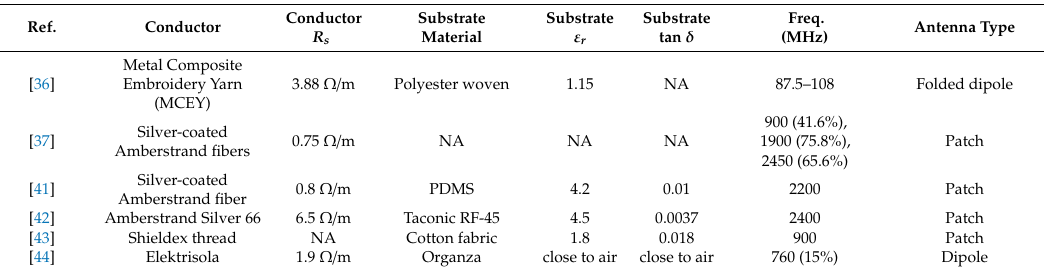
Table 2. Examples for embroidered